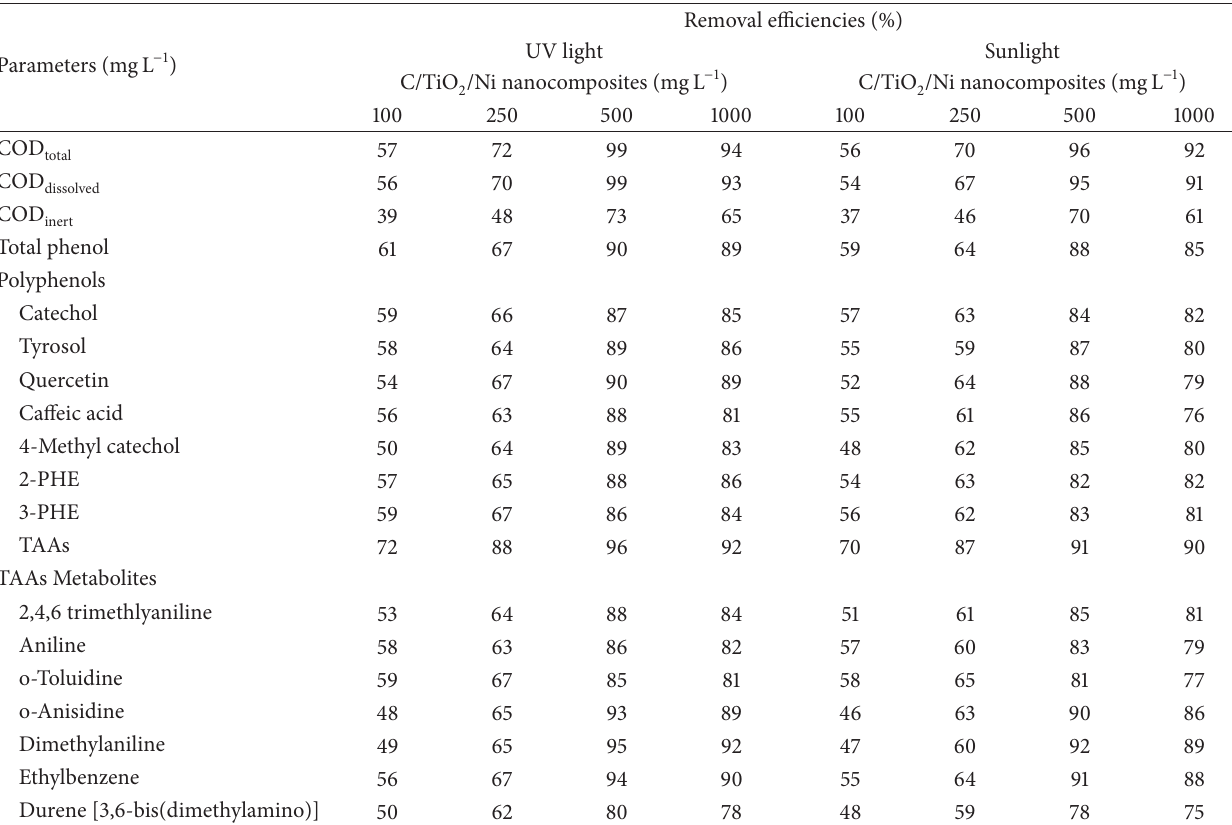
Table 3: Effect of increasing C/TiO /Ni nanocomposite concentrations on the removals of OMW during photocatalytic degradation, under 2 300 W UV and 30 W sunlight irradiations, at pH = 7.0, and at 25 ∘ C, after 60 min ( 𝑛 = 3, mean